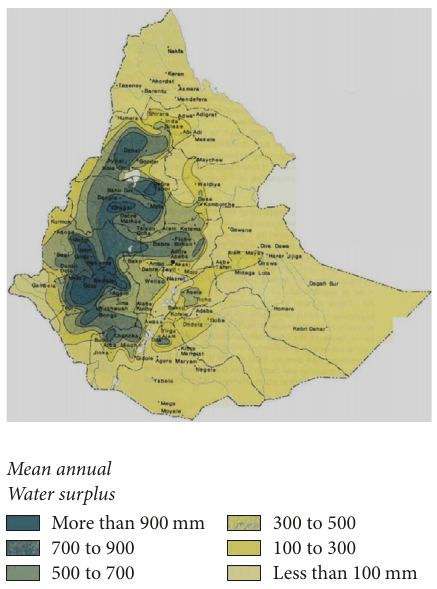
Figure 1: Distribution of MHP potential sites in Ethiopia